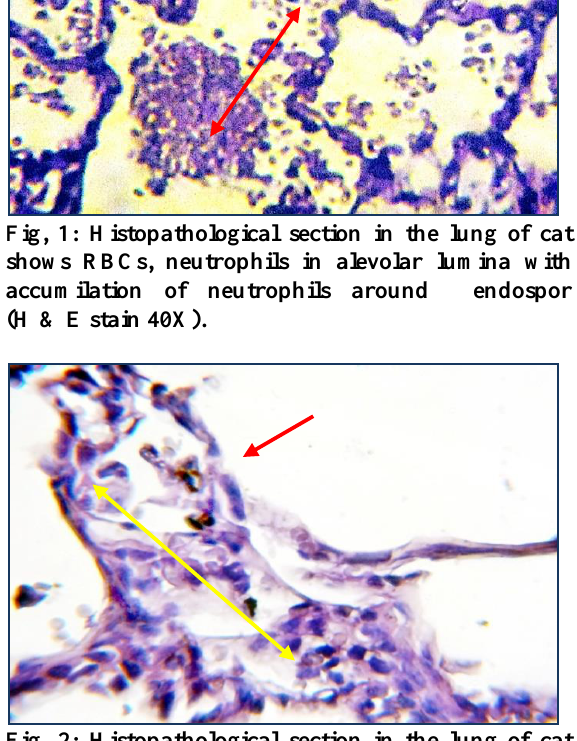
Fig, 5: Histological section in the intestine of cat showing hyperplasia of lymphoid tissues in peyers patch (H&Estain